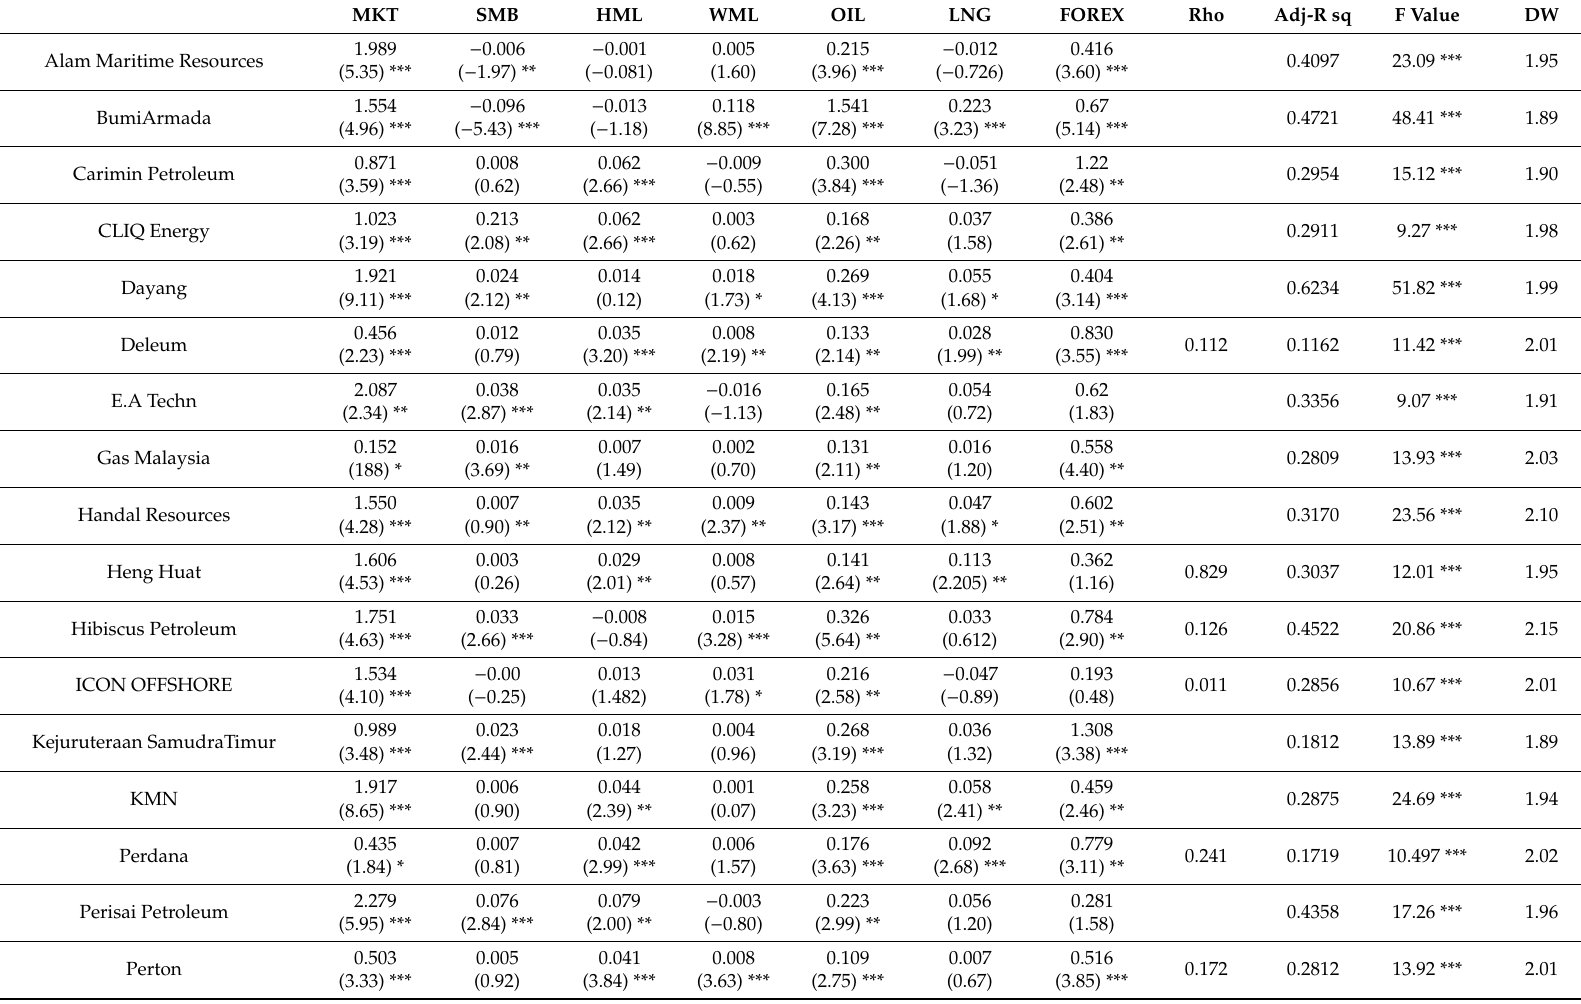
Table 4. Results of Time Series Regression under Mean Semi-Variance Framework (Downside Risk